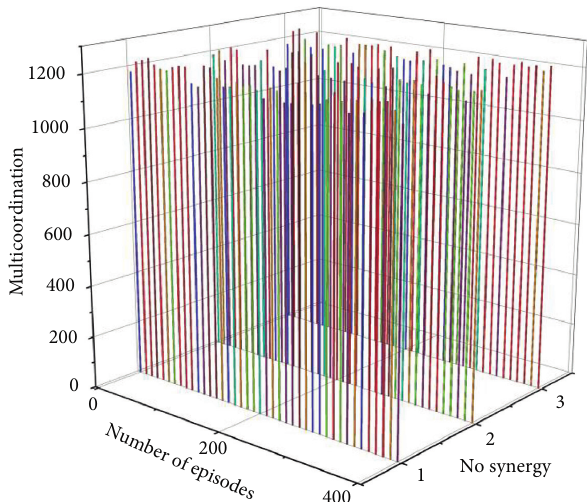
Figure 5: Comparison of the system performance with different numbers of channels.